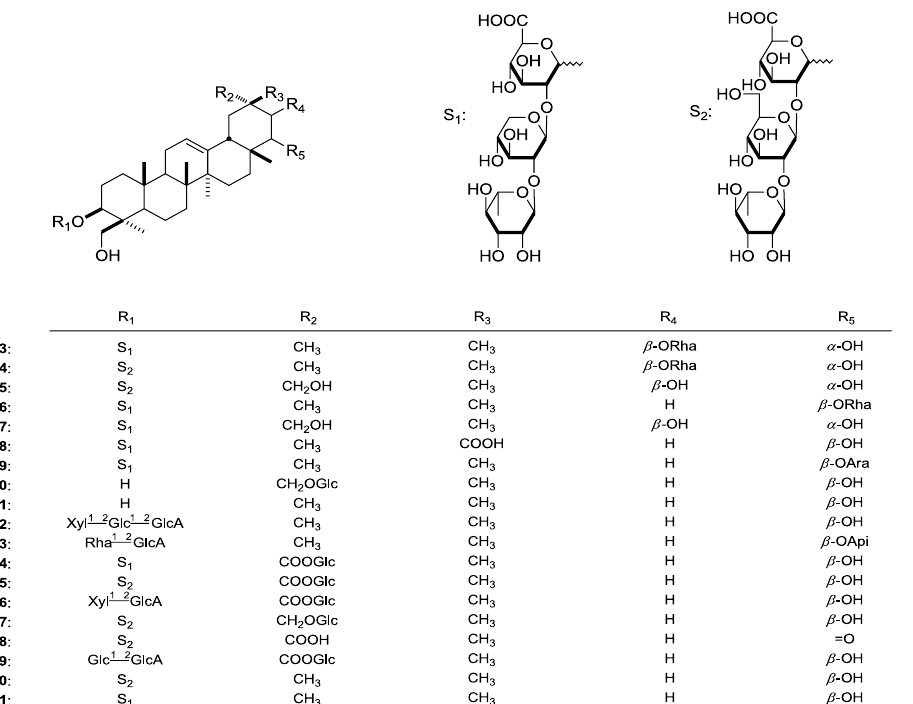
Figure 2. The structures of compounds 143 – 161 obtained from the Astragalus genus.